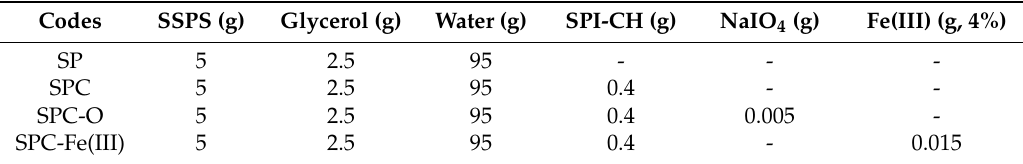
Table 1. Feed composition and summary of soy-based composite